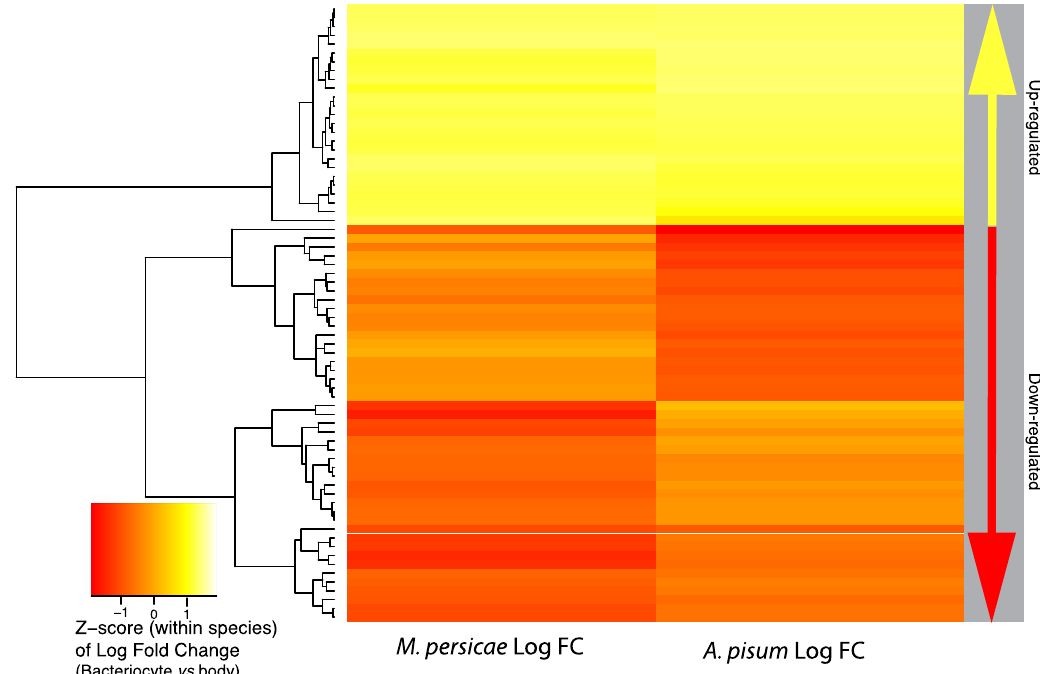
Figure 3. Inter-species ortholog comparison of the top 70 one-to-one orthologs with the greatest variance in standardized Log fold-change expression of bacteriocytes compared to body tissues for both M. persicae and A. pisum . “Up-regulated” on the right panel indicates up-regulated in bacteriocytes compared to body tissue and “Down-regulated” indicates down-regulated in bacteriocytes compared to body tissue. Each row represents a shared one-to-one ortholog between M. persicae and A. pisum . See detailed ortholog gene numbers and GO terms in Supplemental Fig.